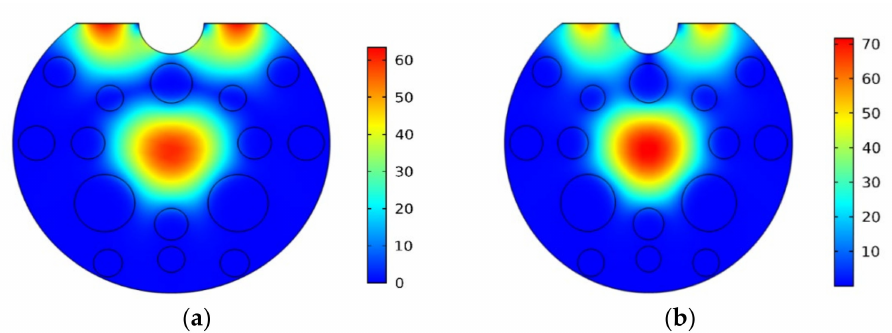
Figure 8. Modal field distribution ( a ) Resonance condition for X-polarization at 1.98 µ m ( b ) Resonance condition for Y-polarization at 1.92 µ